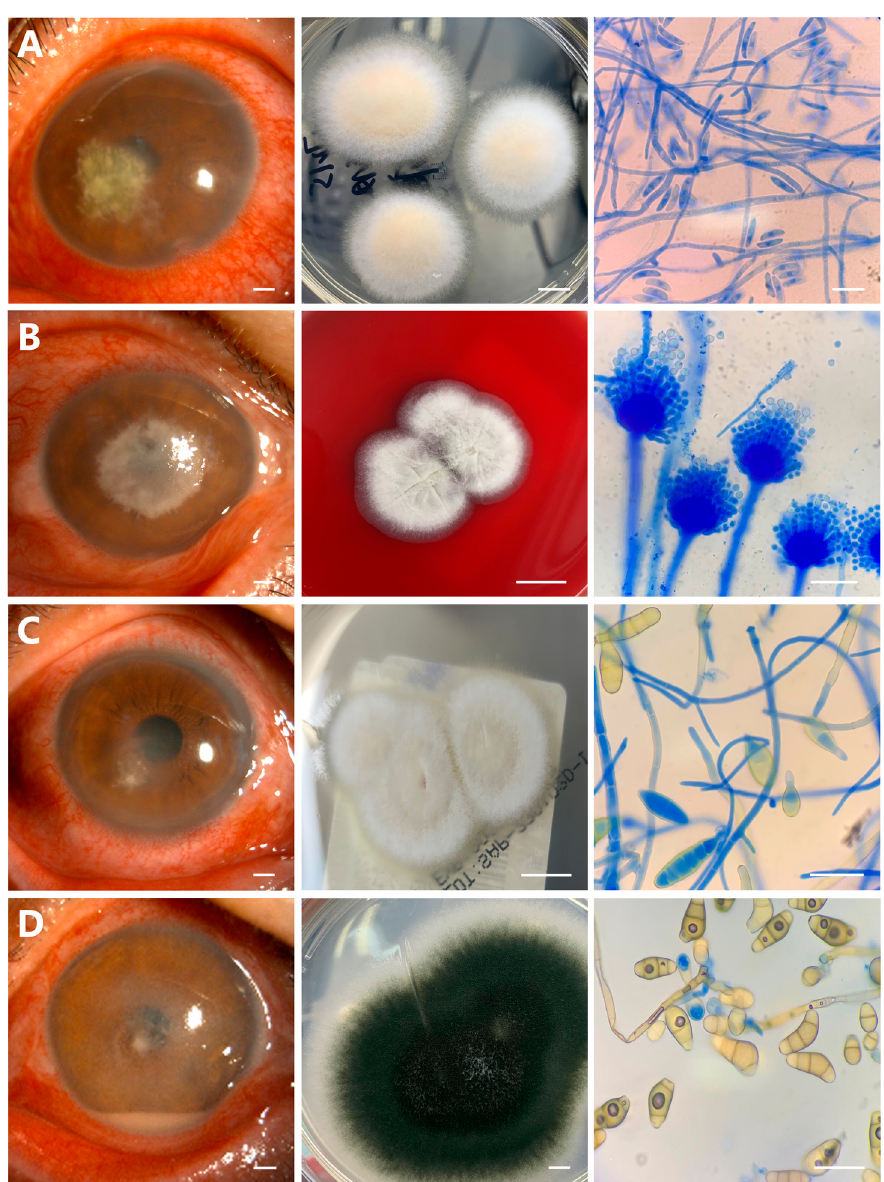
Figure 1. Anterior segment photography, colonies morphology, and lactophenol blue staining of microscopic characteristics of fungal culture species. ( A ) Fusarium species are flat, spreading, wooly colonies, and microscopic examination shows long chains with numbers of conidia and mycelia. ( B ) Aspergillus species grow gray-green to dark-green in color with a white border, hairy colonies, and microscopic examination shows conidia located on the branches. ( C ) Alternaria species colonies are gray flocculated mold, microscopic examination shows long chains of abundant rod-like conidia. ( D ) Curvularia species colonies are black and fluffy aerial hyphae, and microscopic examination shows conidiophores are branched, uniformly brown, septated and curved. (Scale bars = 1 mm in the left; 1 cm in the middle; 50 µ m in the right